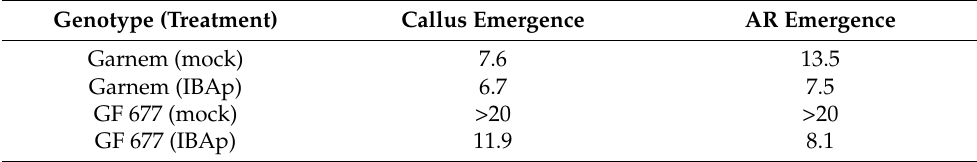
Table 3. RR50 values (expressed in dae) obtained for callus and AR emergence from E3. Genotype (Treatment) Callus